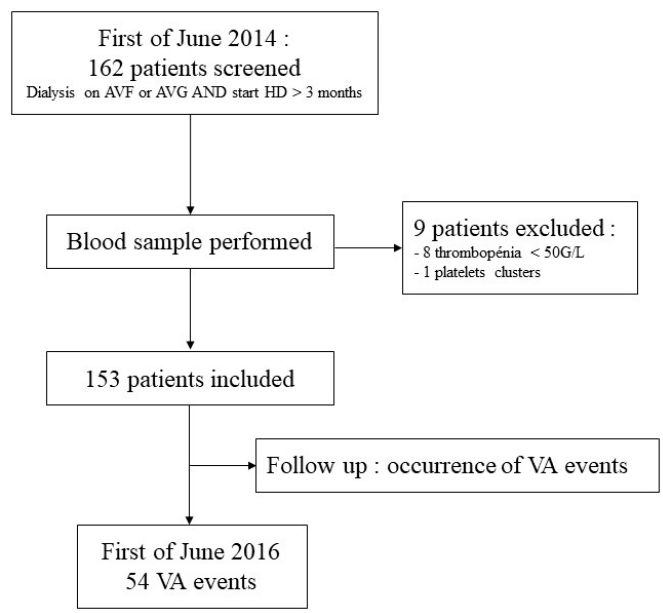
Figure 1. Flow chart 1.